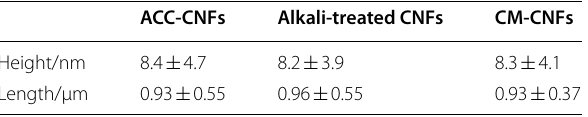
Table 1 Height and length values of ACC-CNFs, alkali-treated CNFs and CM-CNFs, calculated on the basis of their AFM images